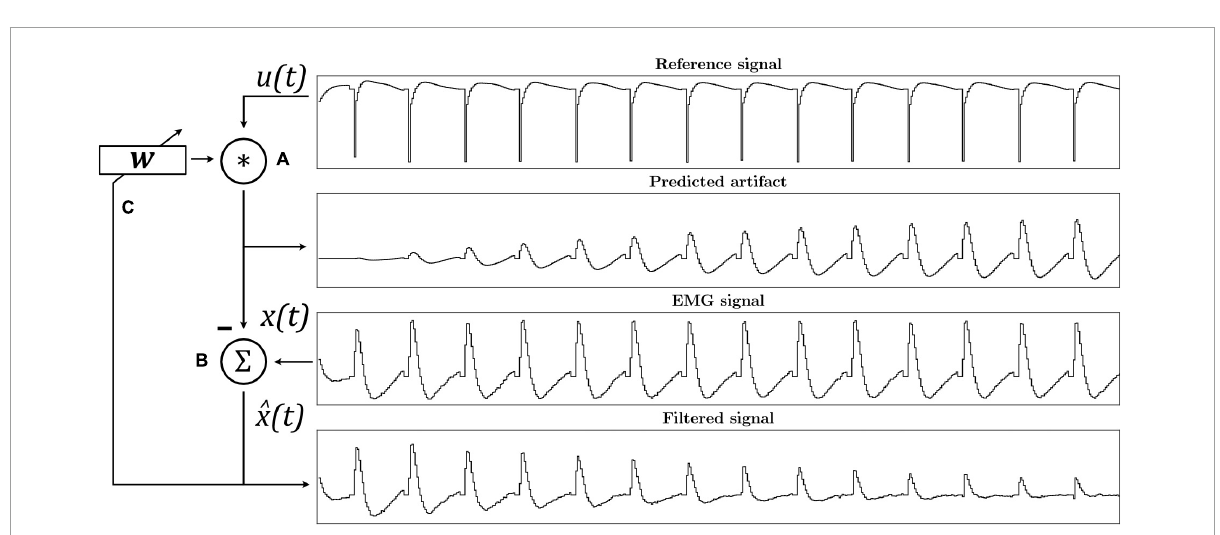
FIGURE2 The ε -Normalized Least Mean Squares ( ε -NLMS) adaptive filter algorithm convolutes the reference signal u ( t ) with filter weights w to predict the artifact waveform (A) . The predicted artifact is subtracted from the original signal x ( t ) to yield an estimated artifact-free signal (cid:98) x ( t ) (B) , which is then also used to update the filter weights after each sample (C)